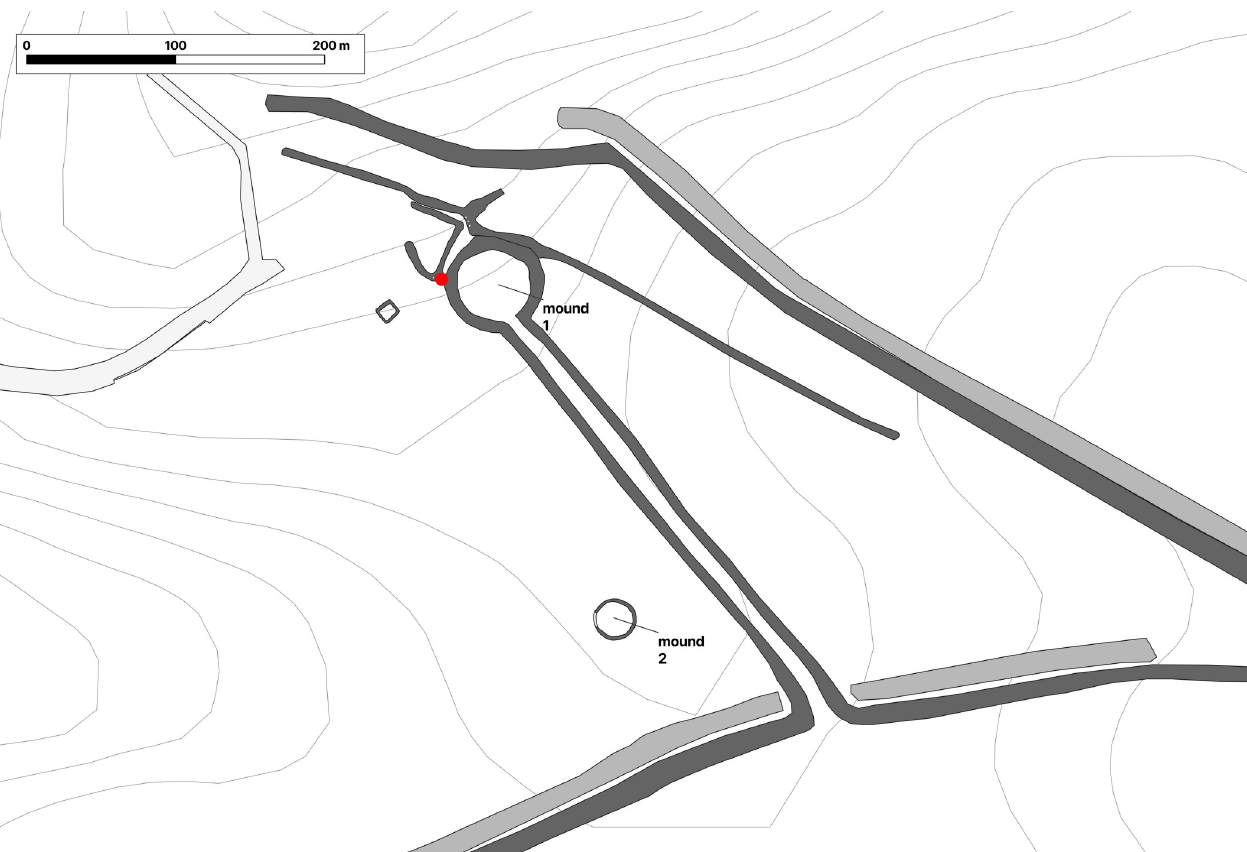
Fig 1. Map indication of the findspot of the complete statue and the fragments from at least 3 other sandstone statues in a ditch around burial mound 1 from the Glauberg (graphic: A. G. Posluschny, Keltenwelt am Glauberg).